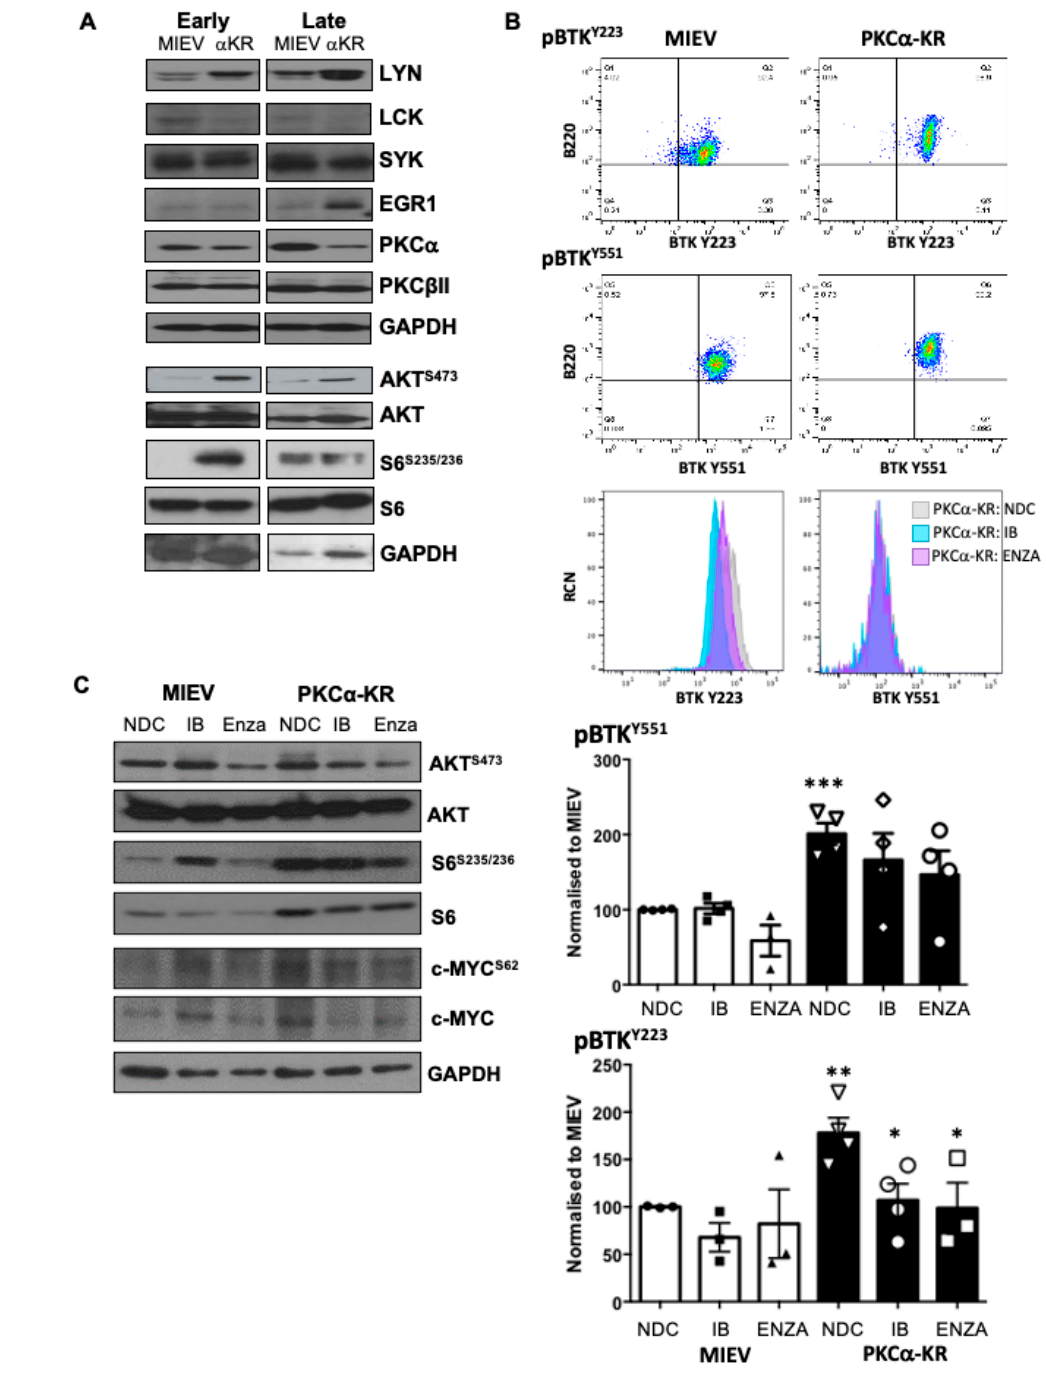
Figure 5. Inhibition of PKC β activity downregulates key proteins in the BCR signalosome in mouse CLL model. ( A ) The expression/activation status of key hubs proximal and distal to the BCR pathway was analysed by Western blotting in early and late co-cultures of MIEV and PKC α -KR cells. Representative Western blots are shown. Densitometry of Western blots for these proteins ( n ≥ 4) is shown in Supplementary Figure S4. ( B ) Phospho-flow was used to analyse the levels of BTK Y551 and BTK Y223 phosphorylation in MIEV (left) and PKC α -KR (right) cells in the presence and absence of either Ibrutinib (IB; 1 µ M) or enzastaurin (Enza; 20 µ M). Upper panel shows the flow cytometry dot plots of the mouse B lineage cells (B220 + ) vs. phospho-BTK, gated on FSC/SSC, while lower histogram plots show the effect of drug treatments on BTK Y551 and BTK Y223 phosphorylation as